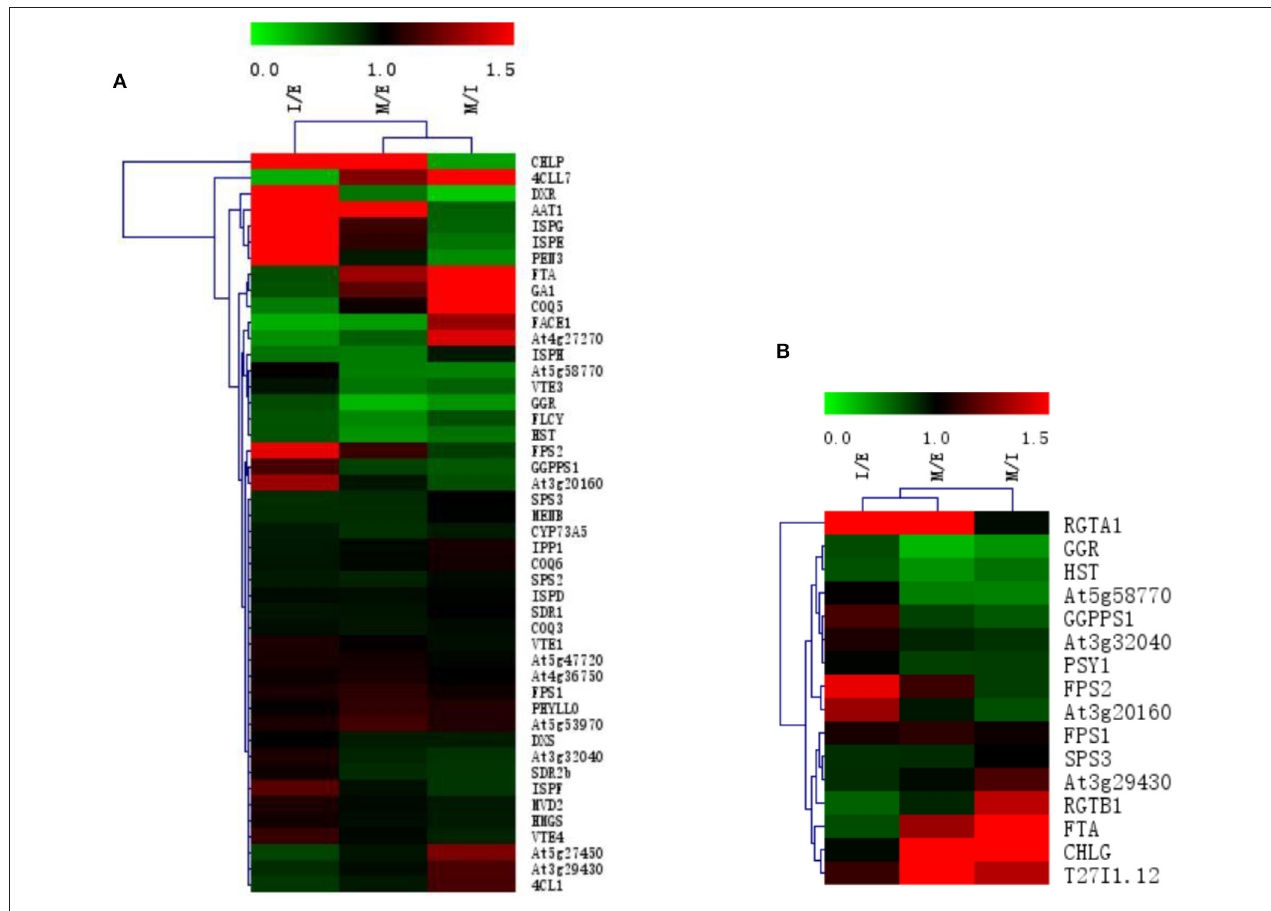
FIGURE 4 | The expression clustering heatmap of some proteins in roots of R. glutinosa. (A) The expression of proteins associated with terpenoid synthesis in R. glutinosa ; (B) The expression of prenyltransferase in R. glutinosa. I/E represents the fold change of protein expression between I stage and E stage of R. glutinosa , M/E represents the fold change of protein expression between M stage and E stage of R. glutinosa , M/I represents the fold change of protein expression between M stage and I stage of R. glutinosa . Green and red color refers to the down or up expression of proteins, respectively. Each line represents the expression of each protein in different groups. Each column represents the expression of all proteins in each